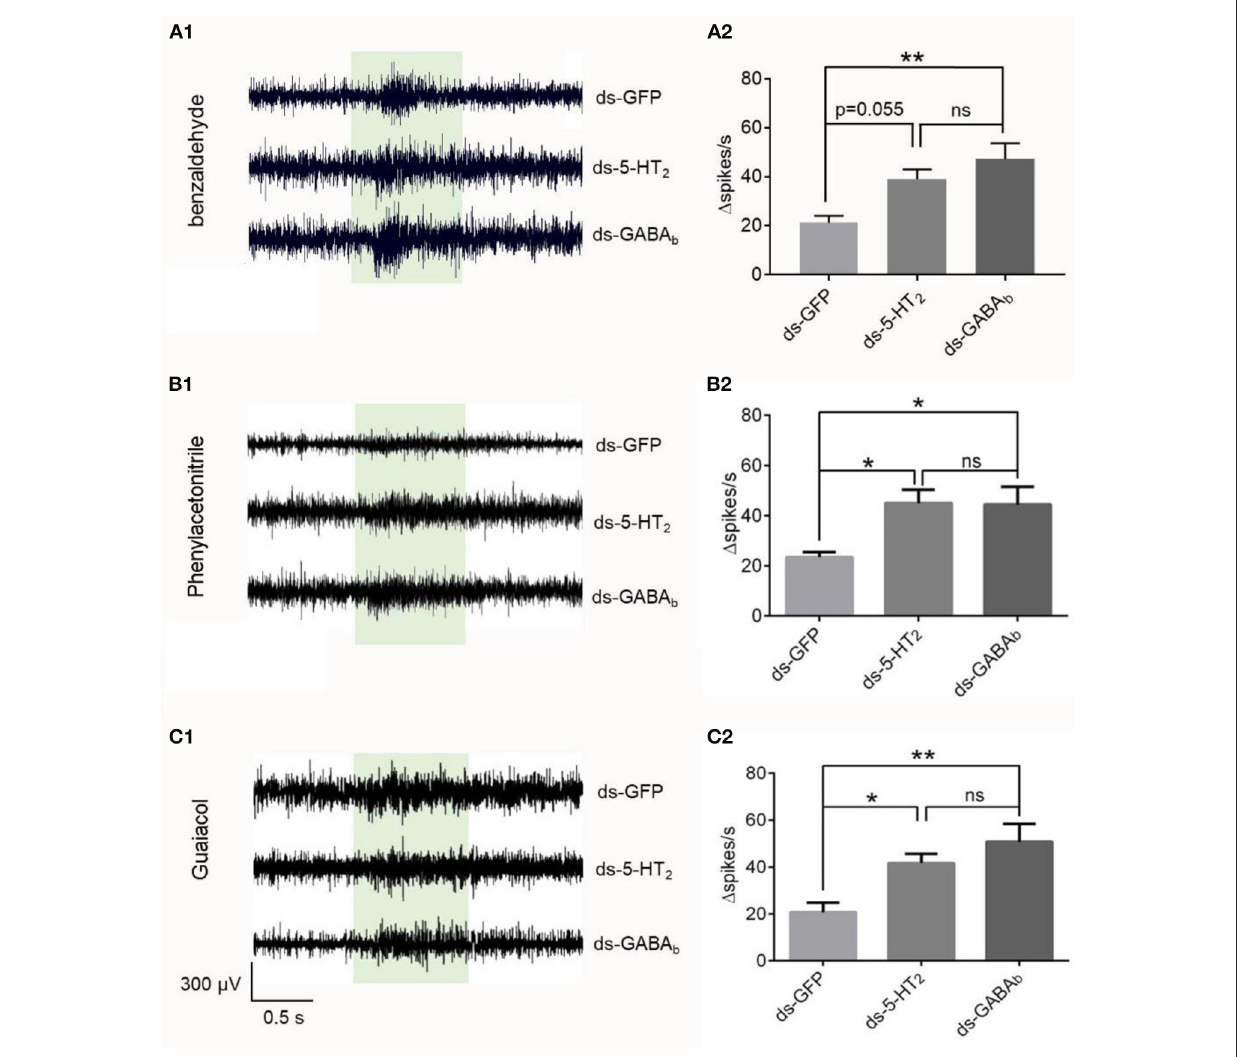
FIGURE6 Responses to odorants at 1% (v/v) concentration of ORNs in isolated antennal basiconic sensilla of locusts microinjected with ds-GFP, ds- Lmig 5-HT 2 , or ds- Lmig GABA b . (A1–C1) Response traces of Ba6 neurons to benzaldehyde, phenylacetonitrile, and guaiacol. (A2 – C2) Quantification of the mean changes of all spikes ( 1 spikes/s) in the 1s before and after the stimulus of the Ba6 neurons to odorants in locusts microinjected with ds-GFP, ds- Lmig 5-HT 2 , or ds- Lmig GABA b . * p < 0.05, ** p < 0.01. ns, no significant